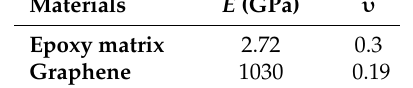
Table 2. Mechanical properties of the constituents.